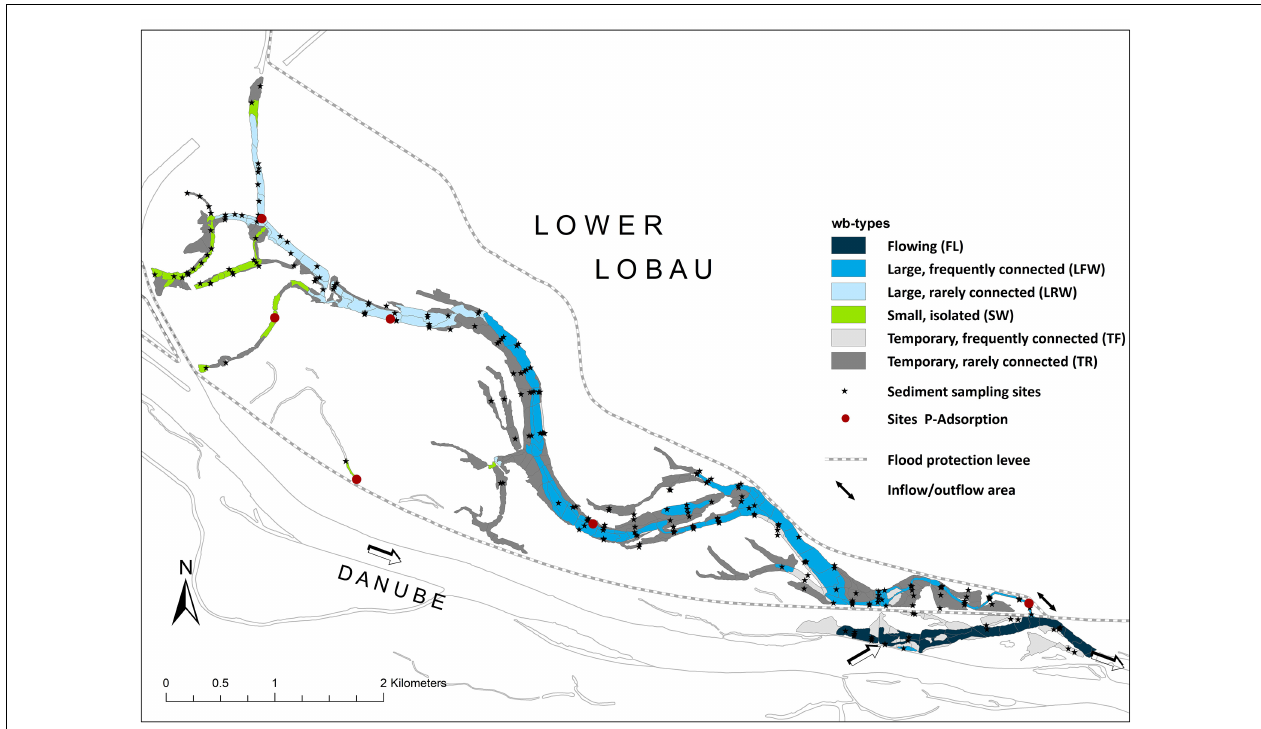
FIGURE 1 | Study area Lower Lobau (area: 1,480 ha), sediment and water column sampling sites, and sites where adsorption/desorption experiments were done are shown. Arrows indicate inflow/outflow areas of the